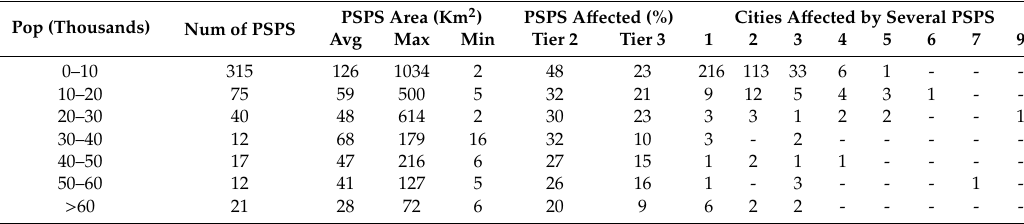
Table 1. Cities in PG&E PSPS under Tier 2 (Elevated) or Tier 3 (Extreme) Fire-Threat.